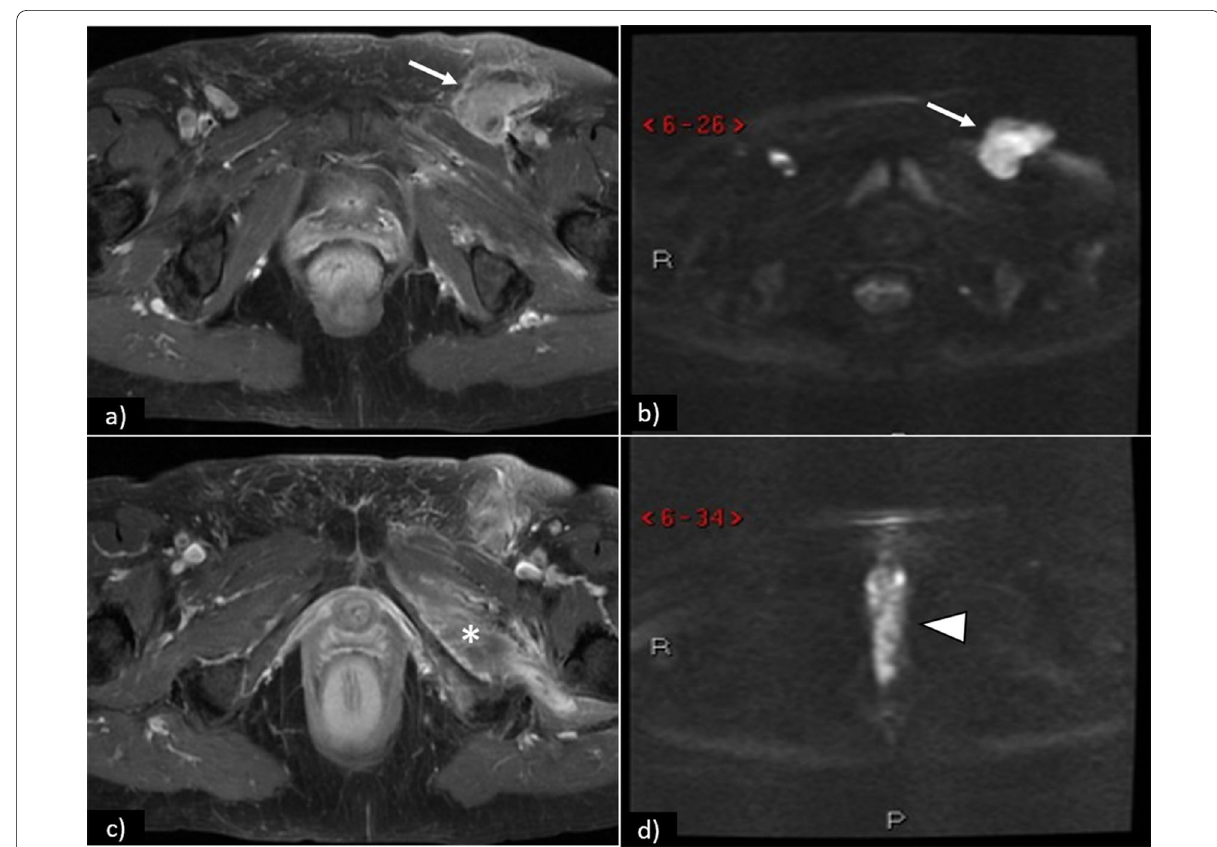
Fig. 8 Axial contrast‑enhanced T1WI a shows left inguinal lymphadenopathy (arrow) with restricted diffusion (arrow) on DWI ( b ). At different levels, axial contrast‑enhanced T1WI ( c ) depicts left external obturator muscle involvement (*), and DWI ( d ) shows restricted diffusion of the primary vulvar tumour